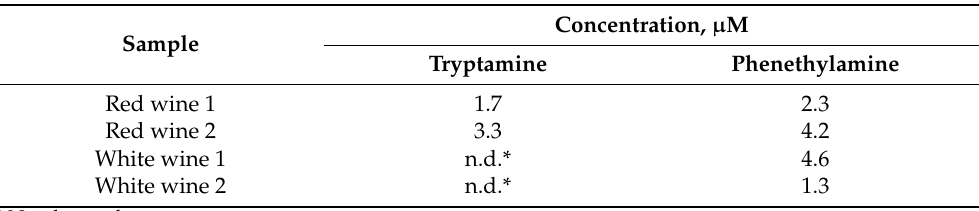
Figure 6. Chromatograms of red wine obtained ( A ) with and ( B ) without UV irradiation, and white wine obtained with ( C ) with and ( D ) without UV irradiation. Table 4. The found concentration of amines in wine